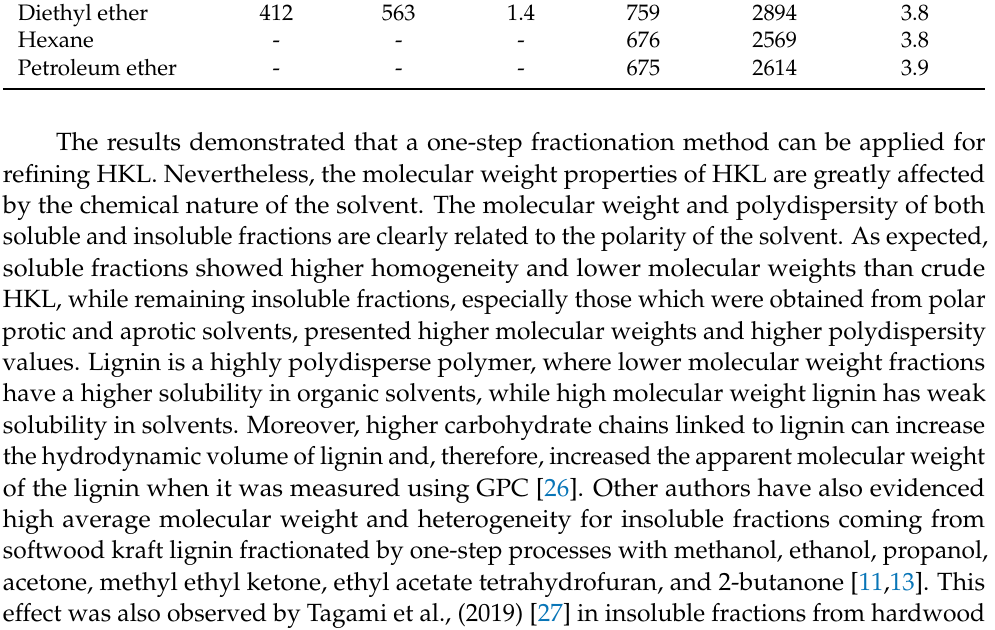
Table 1. Molecular weight-average (Mw), number-average (Mn) and polydispersity (PDI) of HKL and isolated lignin fractions.